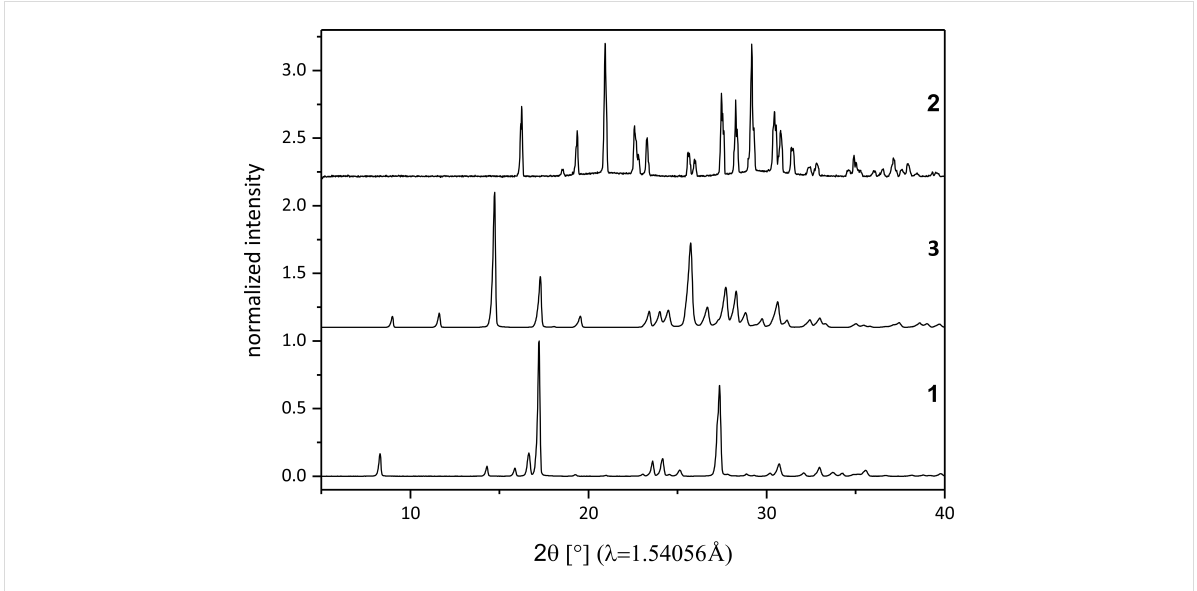
Figure 1: X-ray diffraction patterns of the reactants p -nitrobenzaldehyde ( 1 ) and malononitrile ( 2 ) and the product p -nitrobenzylidenemalononitrile ( 3